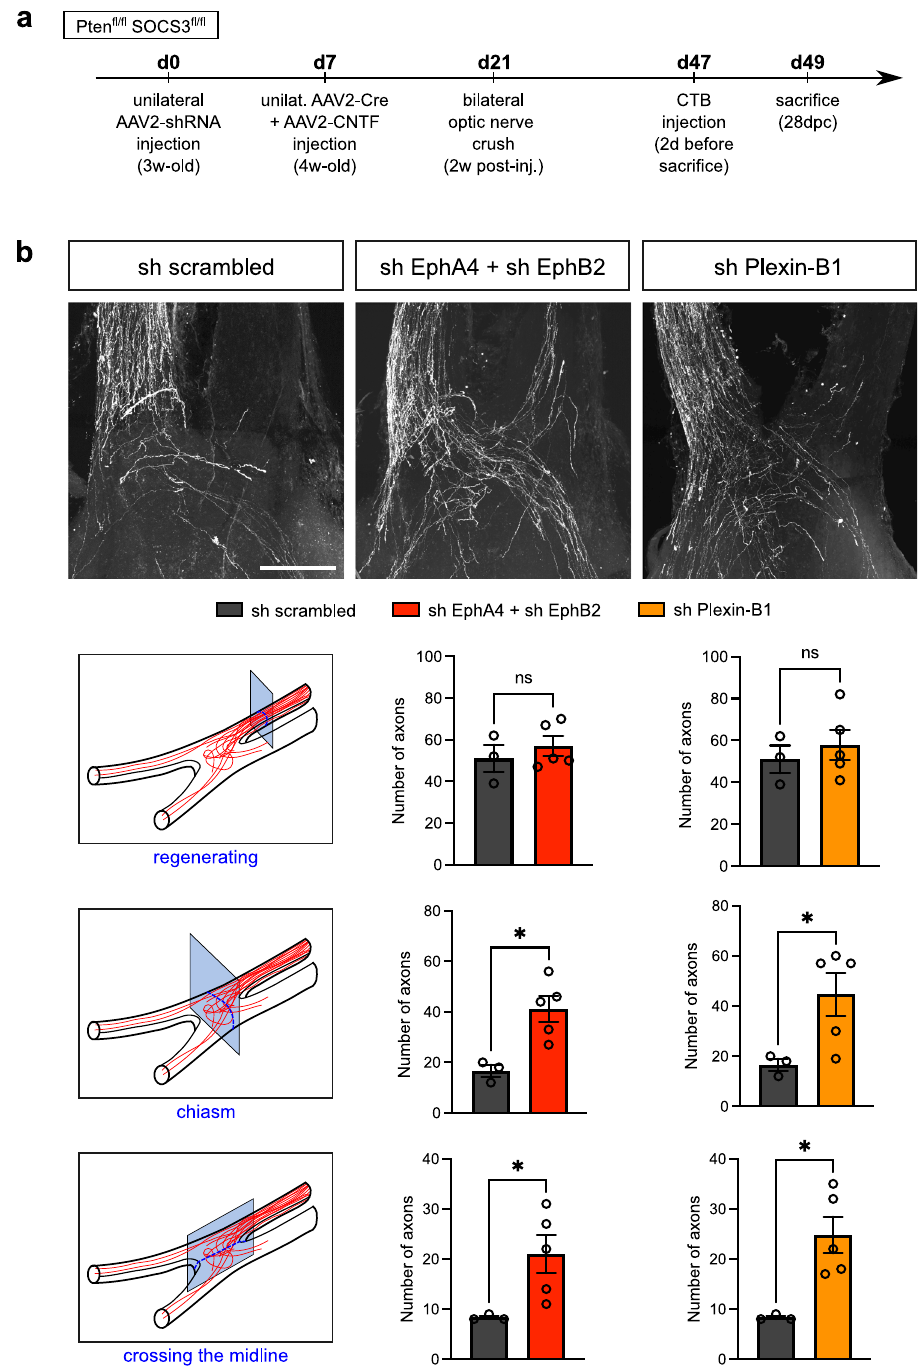
Fig. 8 | Receptor silencing induces a modi fi cation in path fi nding of regener- ating axons in PTEN fl / fl SOCS3 fl / fl mice. a Timeline of the experiment. 3 week- old PTEN fl / fl SOCS3 fl / fl mice were fi rst injected with shRNA EphA4+ shRNA EphB2 or shRNA-Plexin-B1 orshRNAscrambled.7daysafter,AAV2-Creand AAV2-CNTF eye injections were performed. 2 weeks post-injection, mice undergone bilat- eral optic nerve crush and phenotypes were observed 28 days post-crush (28dpc). b Whole optic chiasm confocal images showing regenerative axons labelledwithCTBinPTEN fl / fl SOCS3 fl / fl miceinjectedwithAAV2-shRNA,andAAV2- Cre + AAV2-CNTF at 28dpc, with schematic of quanti fi cation planes and